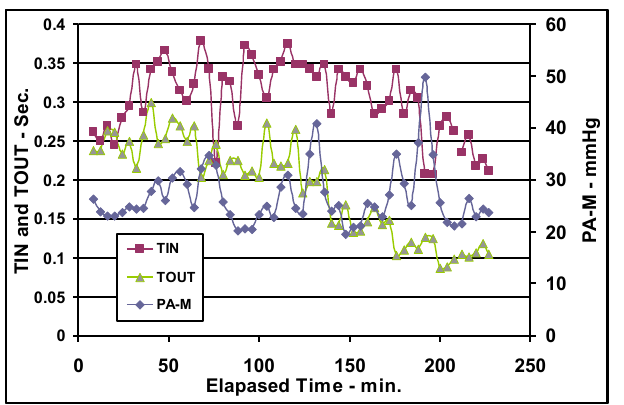
Figure 6. Mean pulmonary arterial pressure [PA-M], time of arterial blood inflow (TIN), and time of venous outflow (TOUT) vs. elapsed time.